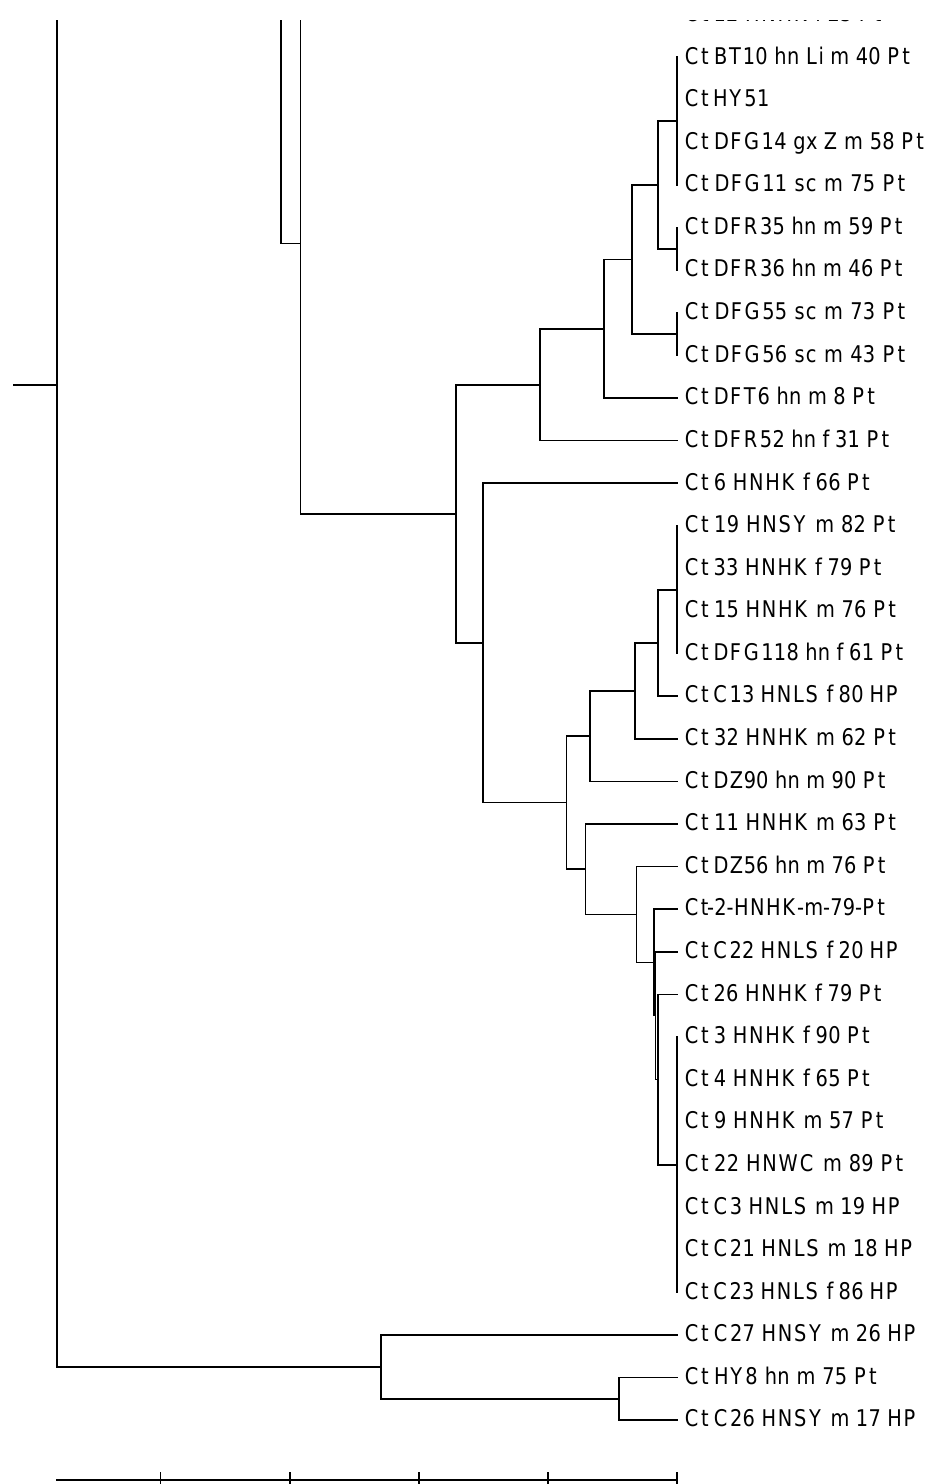
Figure 6. Relationships among strains of C. tropicalis from environmental and clinical sources in Hainan province in tropical China. Strains highlighted in red were from natural environments isolated in this study. The non-highlighted ones were from oral cavities of patients in Hainan reported in our previous study. For detailed strain information, see Ref. [22] and Table S4.